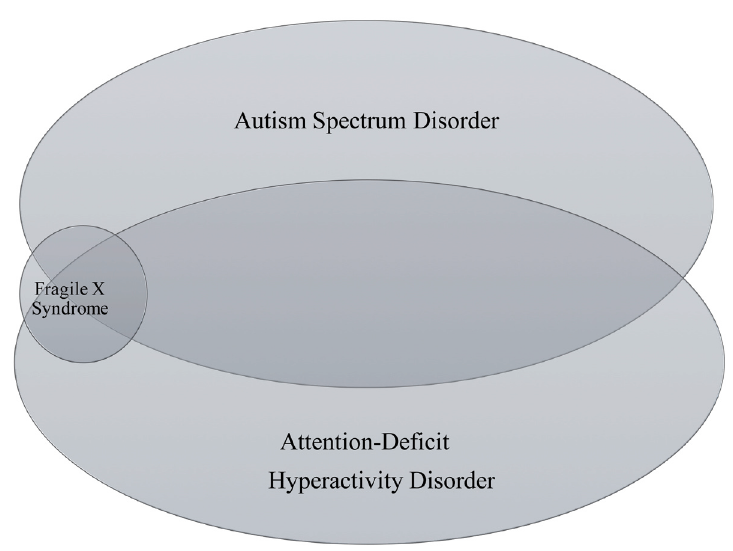
Figure 2. There is significant overlap between fragile X syndrome (FXS), autism spectrum disorder (ASD), and attention-deficit hyperactivity disorder (ADHD). Approximately 60% of all patients with FXS also meet criteria for ASD, although FXS accounts for only 2% to 6% of all cases of ASD. Furthermore, nearly 80% of children with FXS and 50% of children with ASD have co-occurring ADHD 21,22